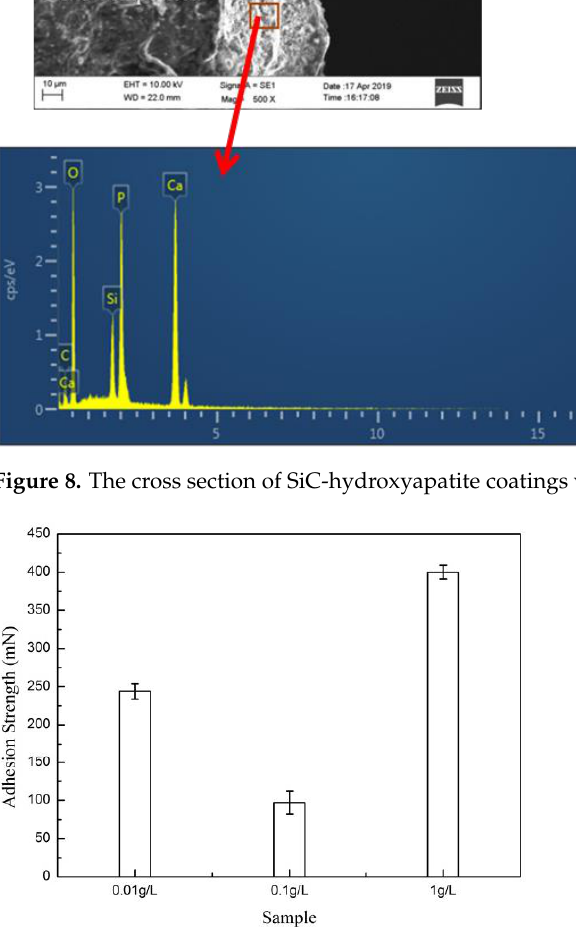
Figure 9. Adhesion strength of SiC-hydroxyapatite coatings at different concentrations of 200 nm SiC particles.